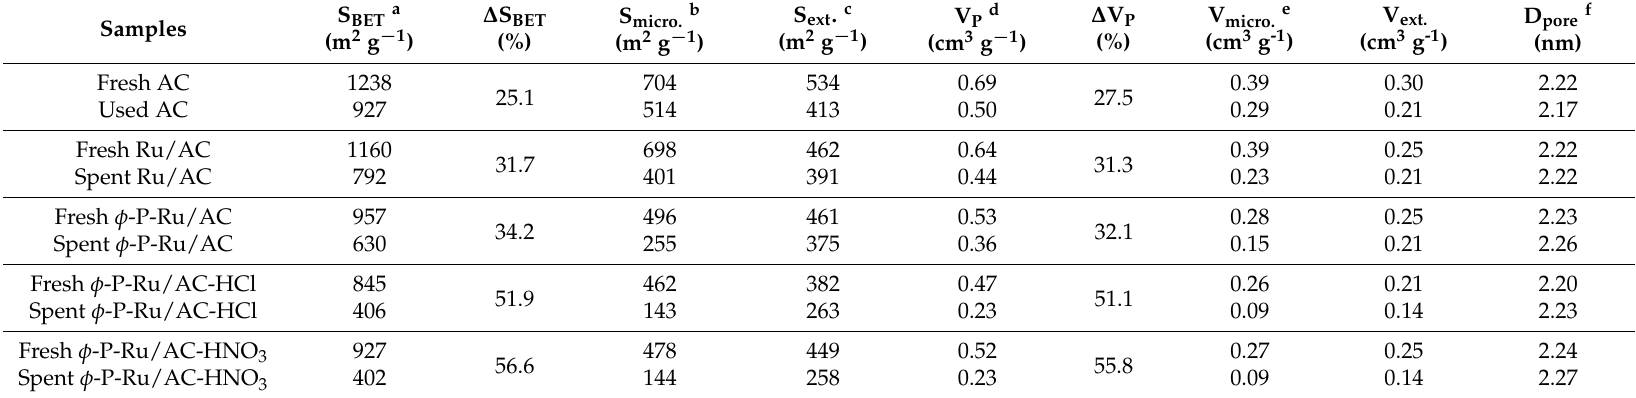
Table 1. Physical properties of the different Ru-based